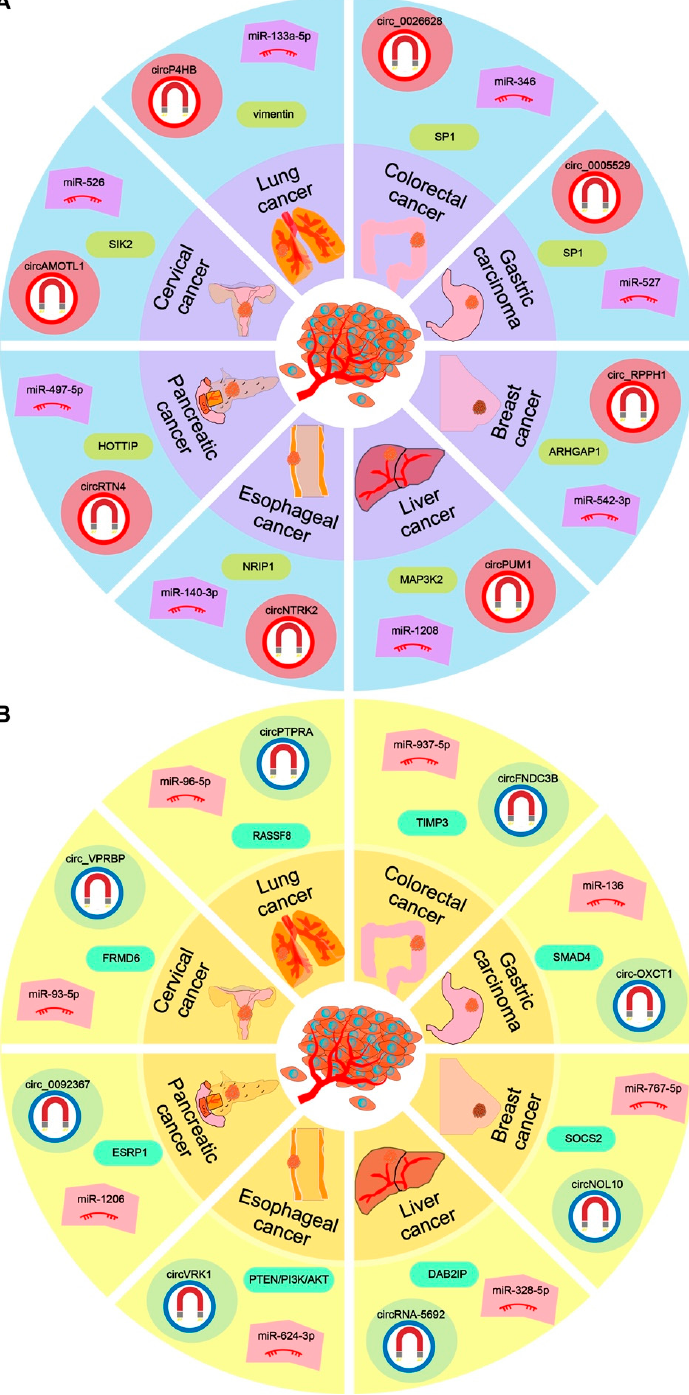
Figure 2. Examples of circRNA-associated ceRNA network based on expression patterns of circRNAs in cancers. ( A ) The RNA interactions based on down-regulated circRNA in specific cancer that may have a potential tumor suppressor role; ( B ) The RNA interactions based on up ‐ regulated circRNA in specific cancer that may have a potential tumor oncogene role.